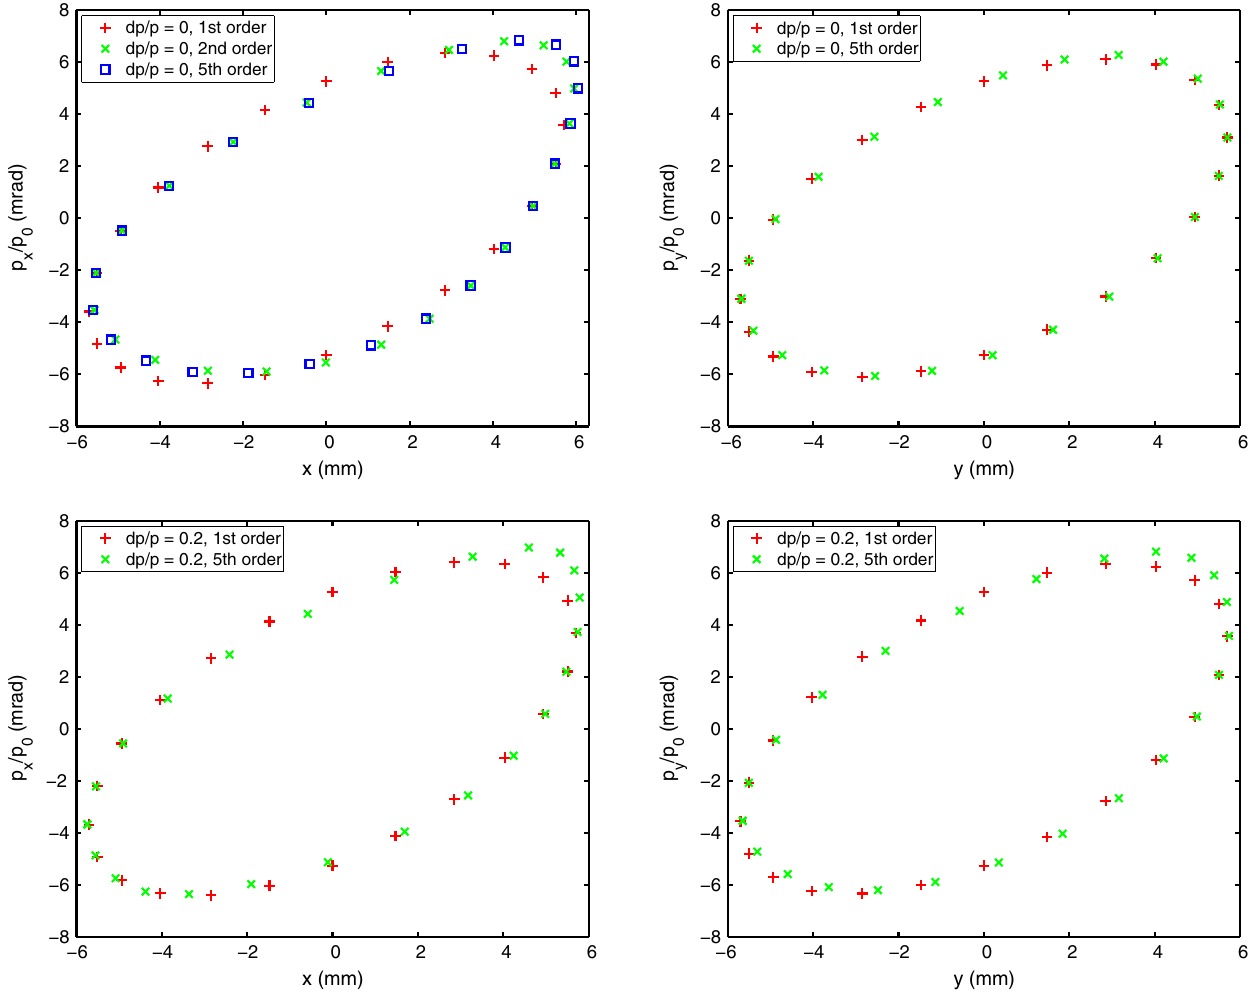
FIG. 15. Final in-plane and out-of-plane phase space at the collimator for Δ p=p ¼ 0% and in-plane (left) and out-of-plane (right) phase spaces at the isocenter. These are just the same as shown in Fig. 14